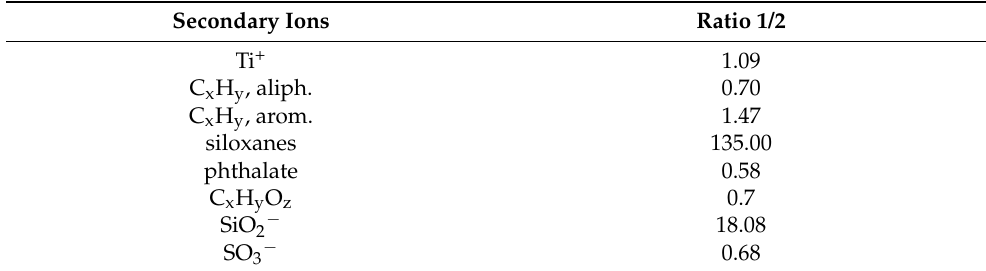
Table 6. Intensity ratio between the particles JRCCNM 62001a (1) and JRCNM 62002a (2); data normalized to Al + and AlO 2 − , respectively.